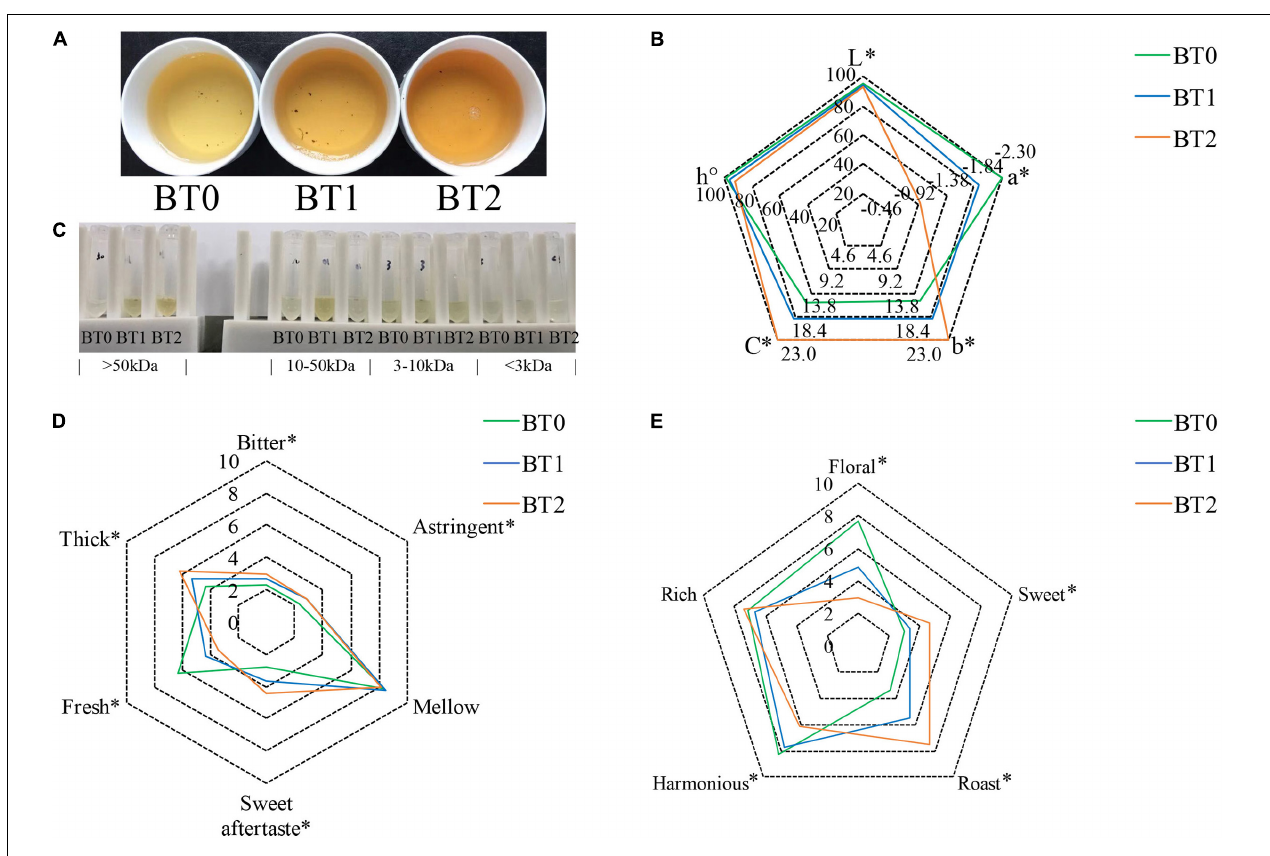
FIGURE 1 | Sensory properties of jade (BT0), medium baked (BT1), and deep baked (BT2) Tieguanyin oolong teas. (A) Photo of tea infusions; (B) the color analysis determined by a spectrophotometer; (C) photo of tea infusion constituents separated using centrifugal filters with 3, 10, and 50 kDa molecular weight cut-off, accordingly; (D) taste characteristics and scores; and (E) aroma characteristics and scores. ∗ P < 0.05 indicates significant difference.